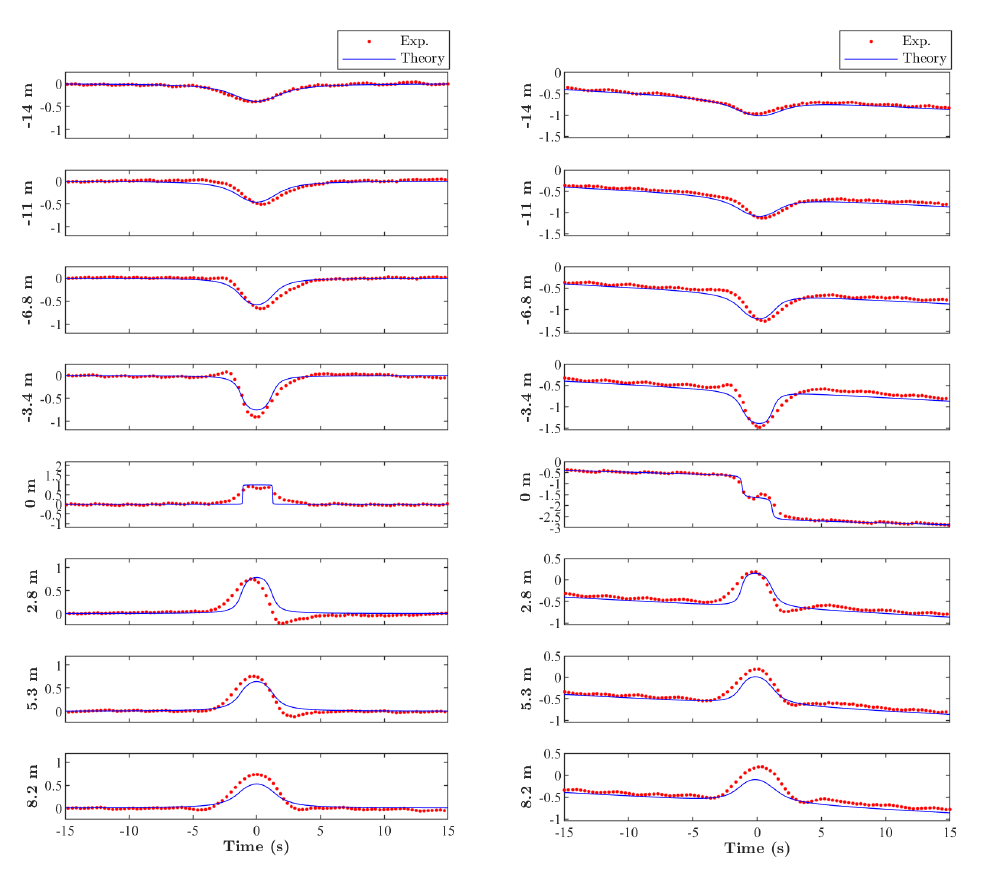
Figure 7. Experimental (red dots) and theoretical (blue lines) phase evolution along the wave tank corresponding to the surface evolution measurements of Figure 5 for the time-NLSE ( left ) and space-NLSE ( right